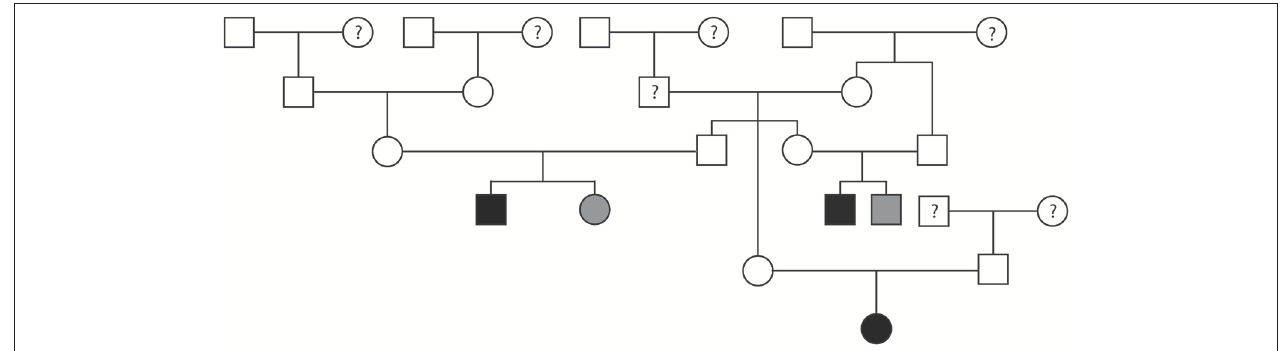
FIGURE 3 | Pedigree representing an extended family of 25 Bullmastiffs phenotyped for subvalvular aortic stenosis (SAS). Affection status is represented as follows: squares represent males, circles represent females, open symbols are SAS unaffected, gray symbols are SAS equivocal, black symbols are SAS affected, and symbols with questions marks have unknown SAS cardiac status.